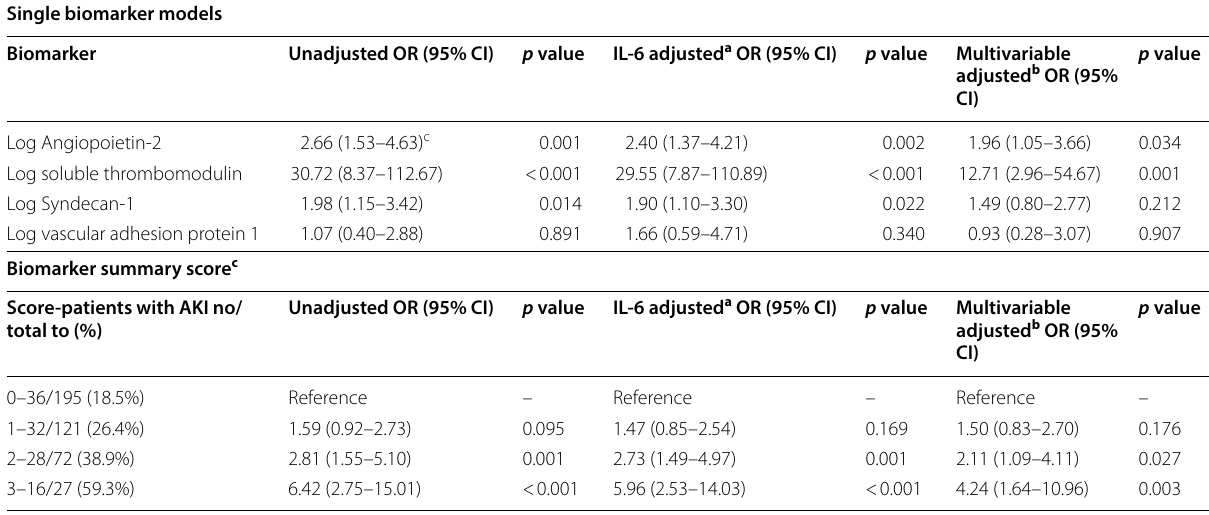
Table 4 Unadjusted and adjusted single and multivariable biomarker logistic regression models for the development of acute kidney injury